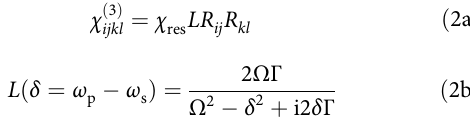
Fig. 1e. Importantly, the directionality of this process results purely from the modi fi ed effective material properties which appear from the point of view of the Stokes wave as a continuously rotating phonon being driven by the rotating electric pump fi eld, which holds right down to the atomic